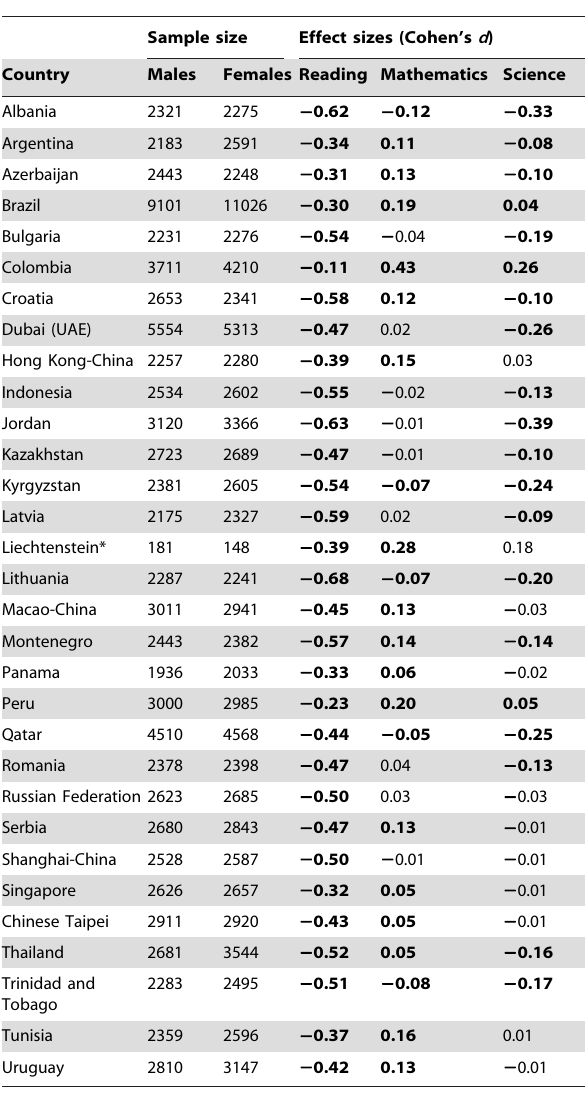
Table 3. National Gender Differences in Reading, Mathematics, and Science Literacy for Countries within the OECD.